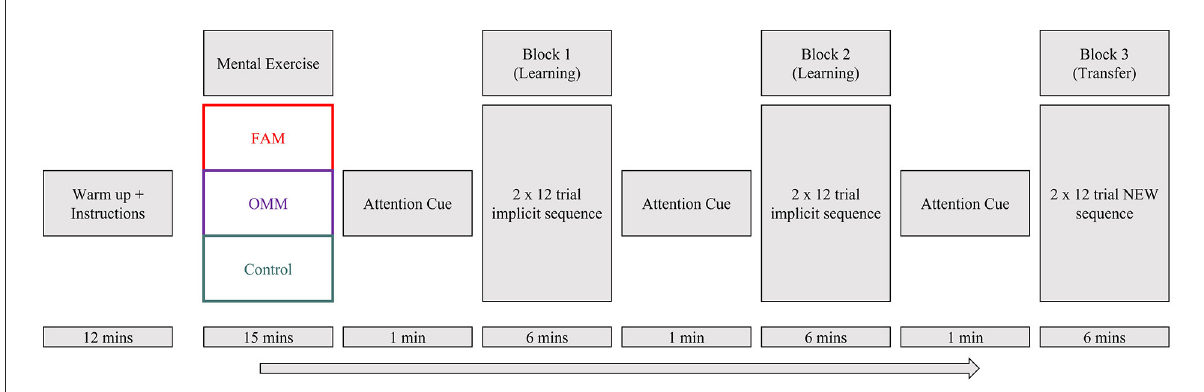
FIGURE2 Experimental procedure. FAM, Focused attention meditation; OMM, Open monitoring meditation. Attention cues verbally reminded athletes to regulate attention in alignment with how they used their attention during the mental exercise.